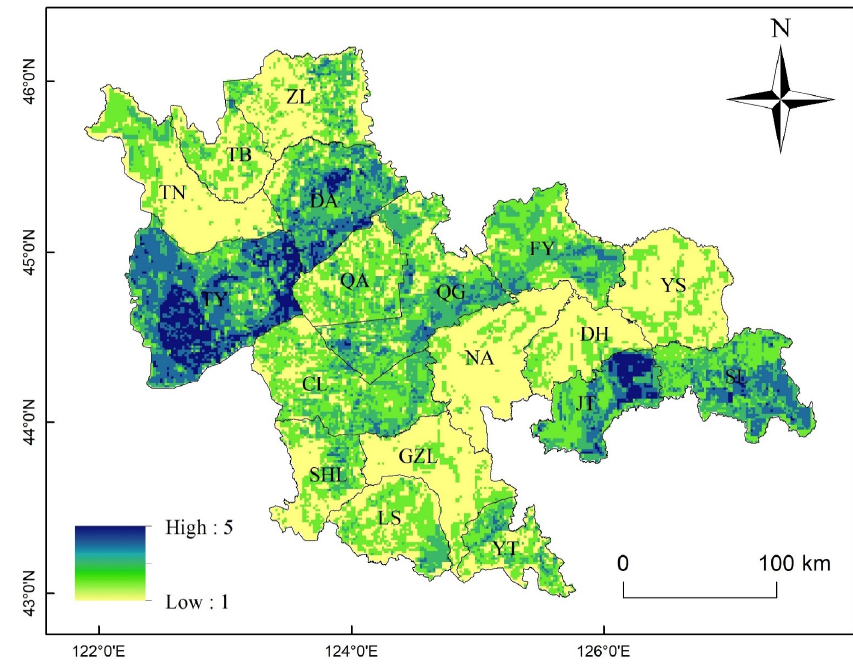
Figure 13. Integrated risk level of agricultural drought.